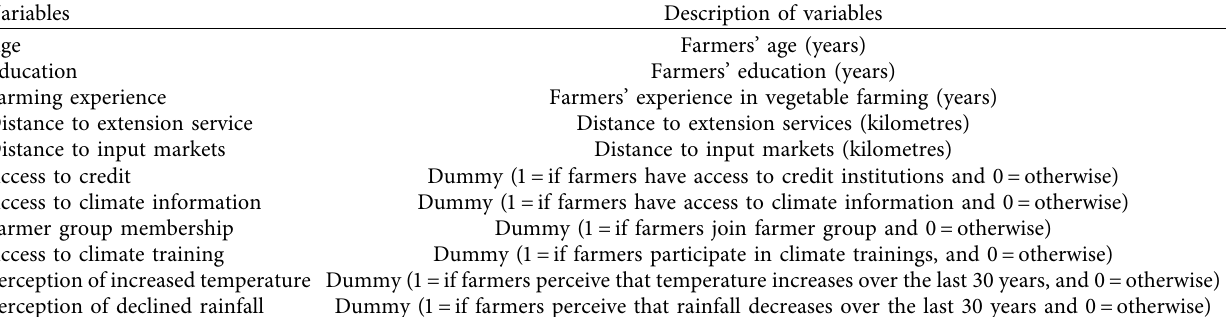
Figure 1: Research sites Table 1: Description of variables.